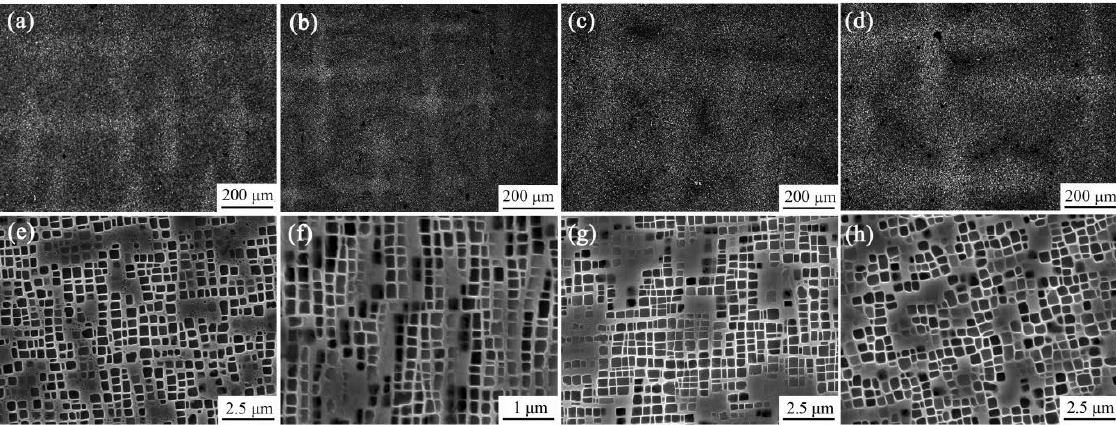
Figure 1. SEM micrographs of the experimental alloys after standard heat treatment. ( a ) and ( e ): E7. ( b ) and ( f ): E71. ( c ) and ( g ): E73. ( d ) and ( h ): E75.